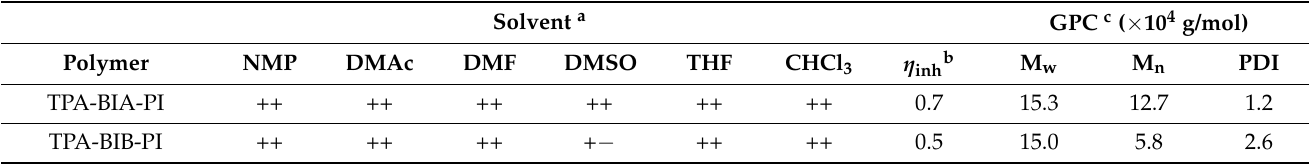
Table 1. Inherent Viscosities, Molecular Weights and Solubilities of the Polyimides.